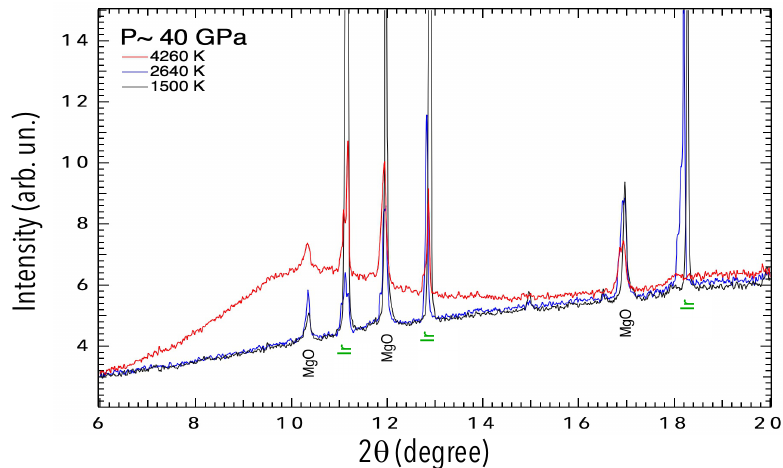
Figure 5. Integrated diffraction signal of Ir embedded in MgO at three different T s (the same as those reported in Figure 4), before and after the melting of Ir. In particular, the appearance of the characteristic diffuse signal from a liquid is clearly visible in the red pattern. MgO and Ir peaks are labeled.